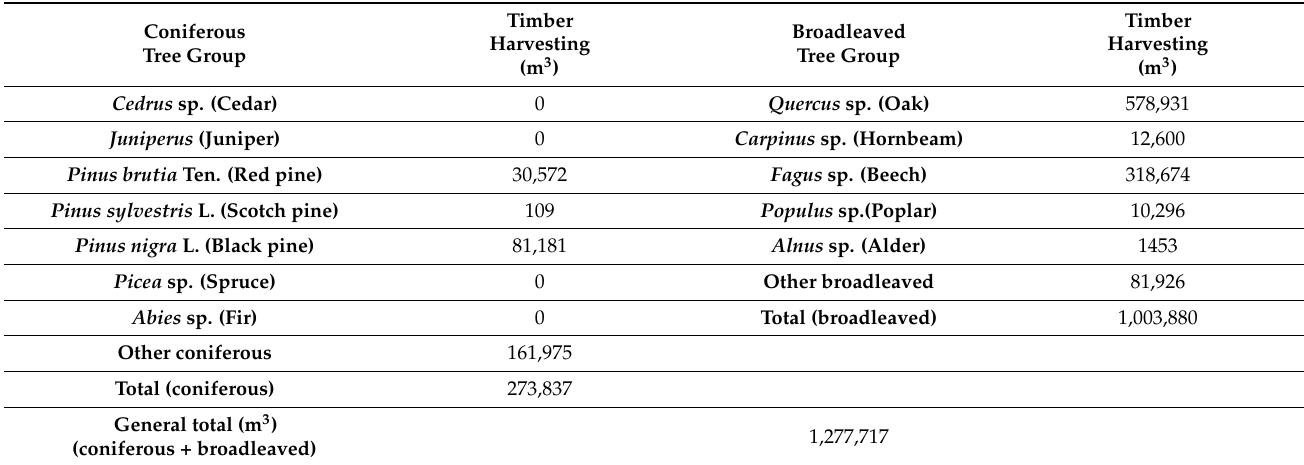
Figure 1. Study area location. Table 1. Timber harvesting values in study area